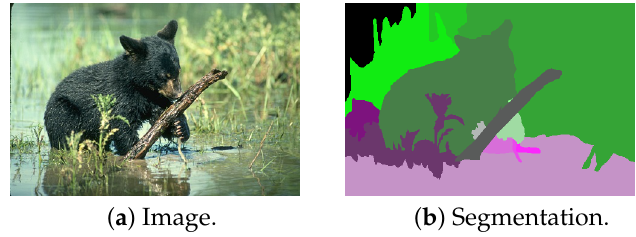
Figure 2. Image segmentation